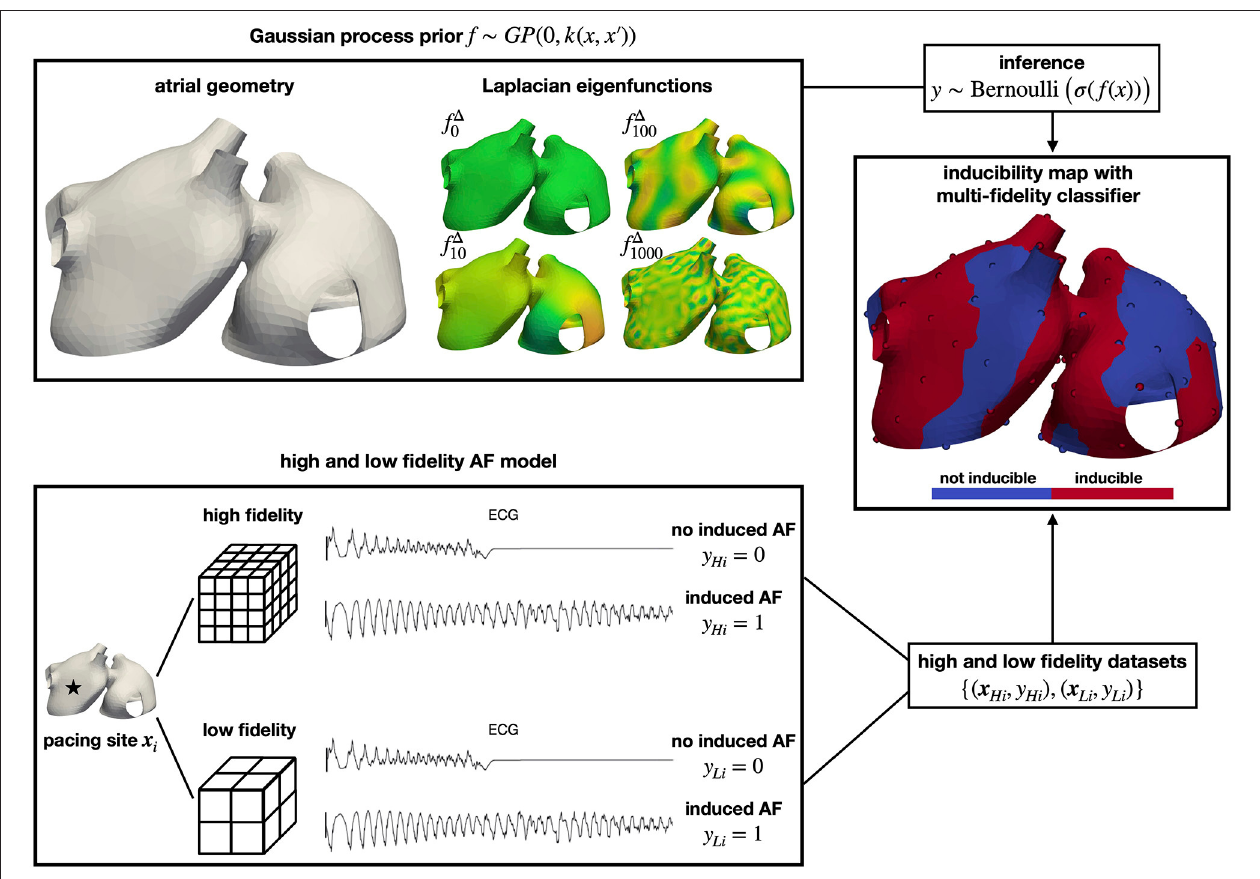
FIGURE 1 | Overview of the methodology. We predict the regions where AF can be induced using a multi-fidelity Gaussian process classifier. We use the Laplacian eigenfunctions of the atrial geometry to efficiently construct a Gaussian process covariance function that operates directly on the manifold surface. We pace different sites in computational models of AF with low and high resolution to create a dataset to train our classifier. In the end, we obtain an inducibility map that can be used to assess treatments.